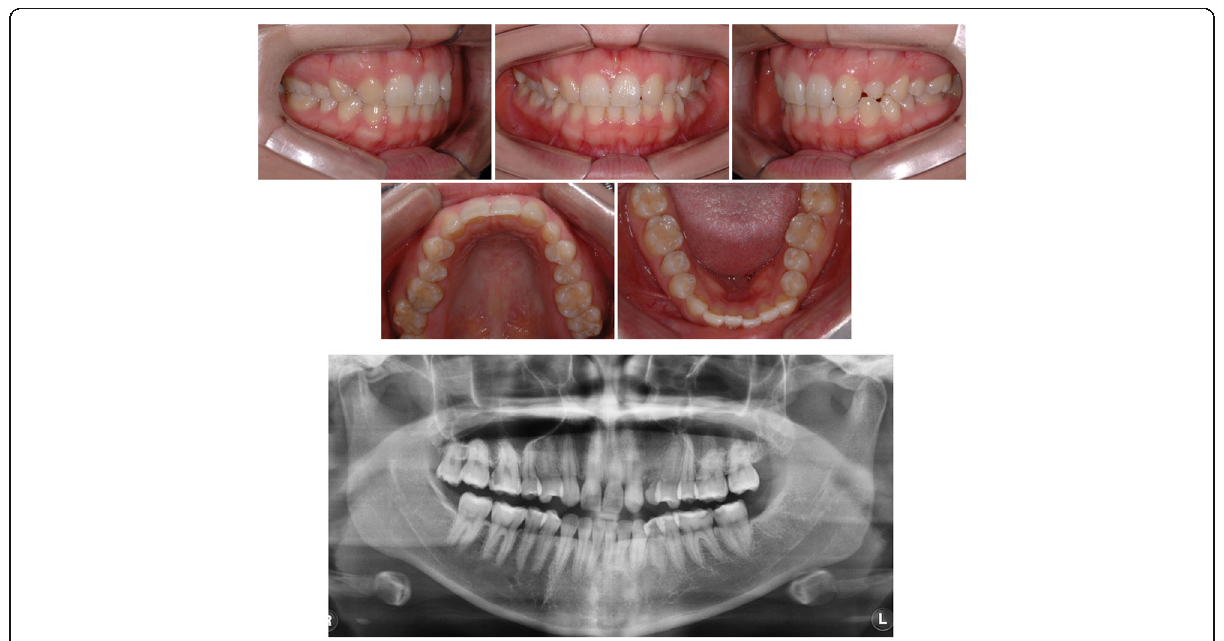
Fig. 1 Pretreatment intraoral photographs and panoramic